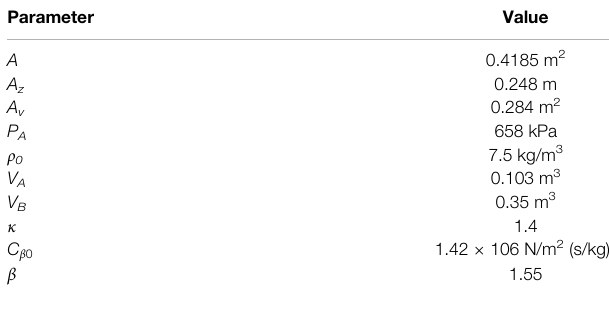
TABLE 1 | Physical parameters of the air